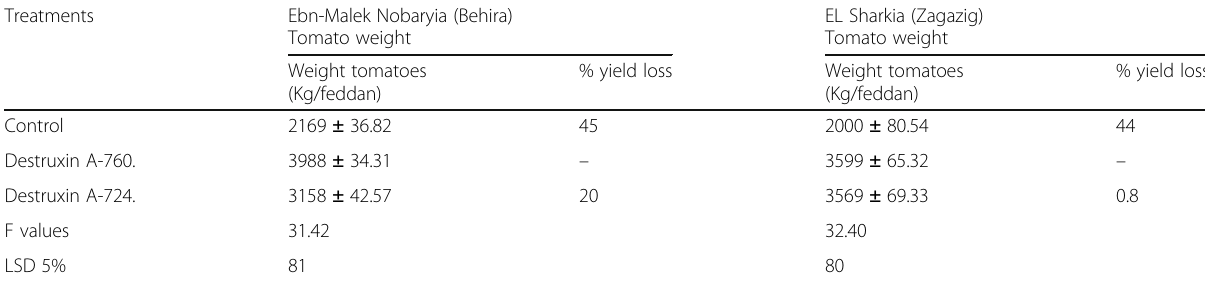
Table 5 Weight of harvested tomatoes and percentage of yield loss during season 2018 post the two-destruxin treatments of M . persicae in two governorates